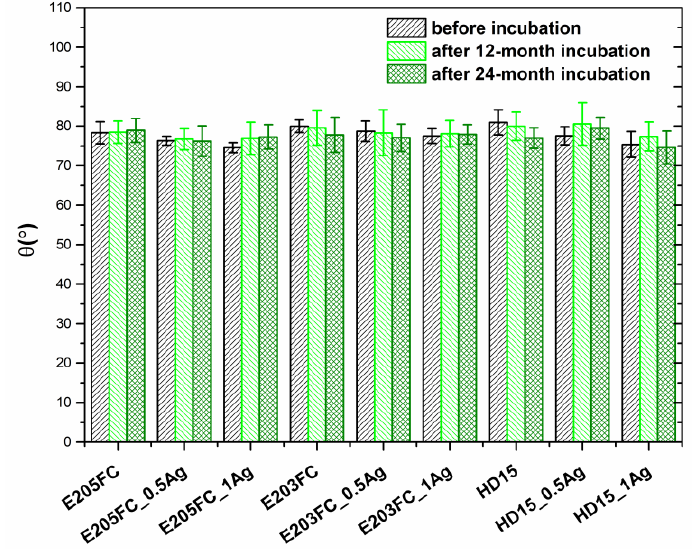
Figure 5. Static water contact angle of pure polymers and polymers containing 0.5 wt % and 1.0 wt % of silver nanoparticles AgNPs. Statistical analysis showed no differences ( p < 0.05) between materials before and after 12- and 24-month incubation.